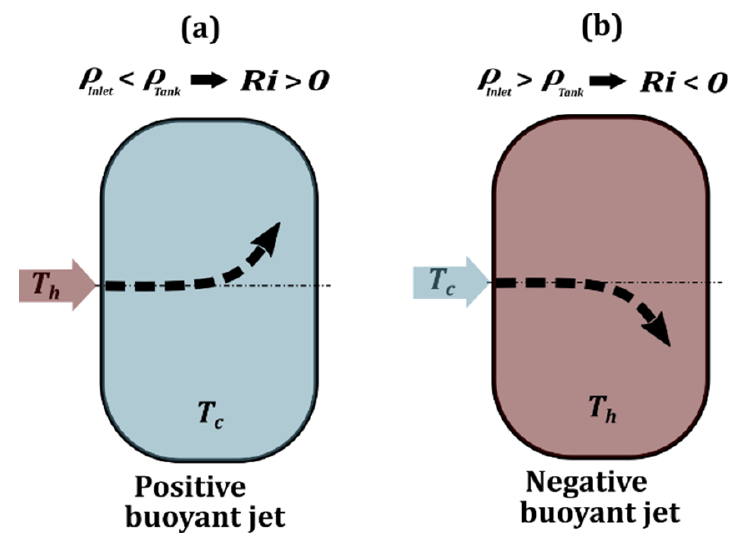
Figure 5. The schematics for the thermal jet. Table 4. Study on the influence of working temperature for thermocline–based TES systems.